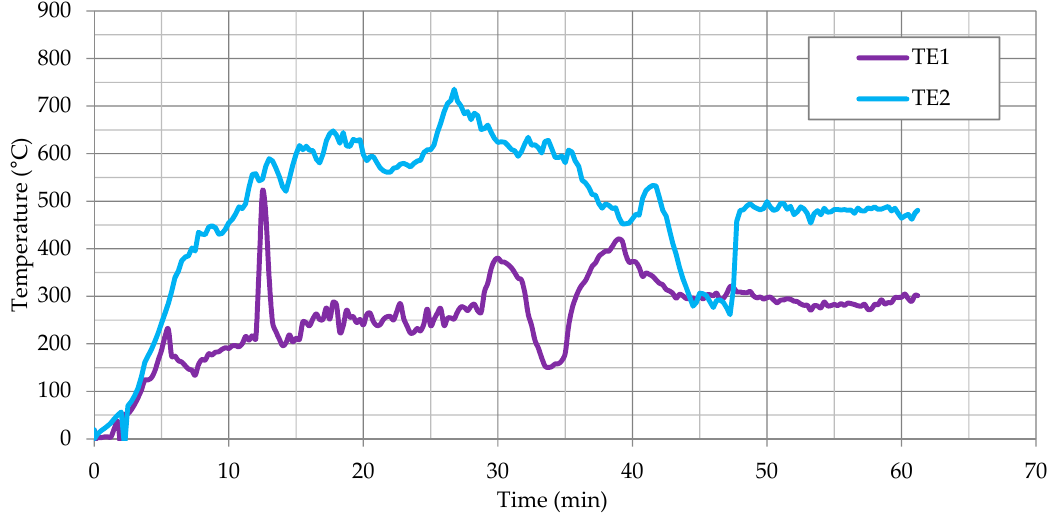
Figure 6. Temperature measurement results for TE1 and TE2 thermocouples. Materials 2020 , 13 , x FOR PEER REVIEW